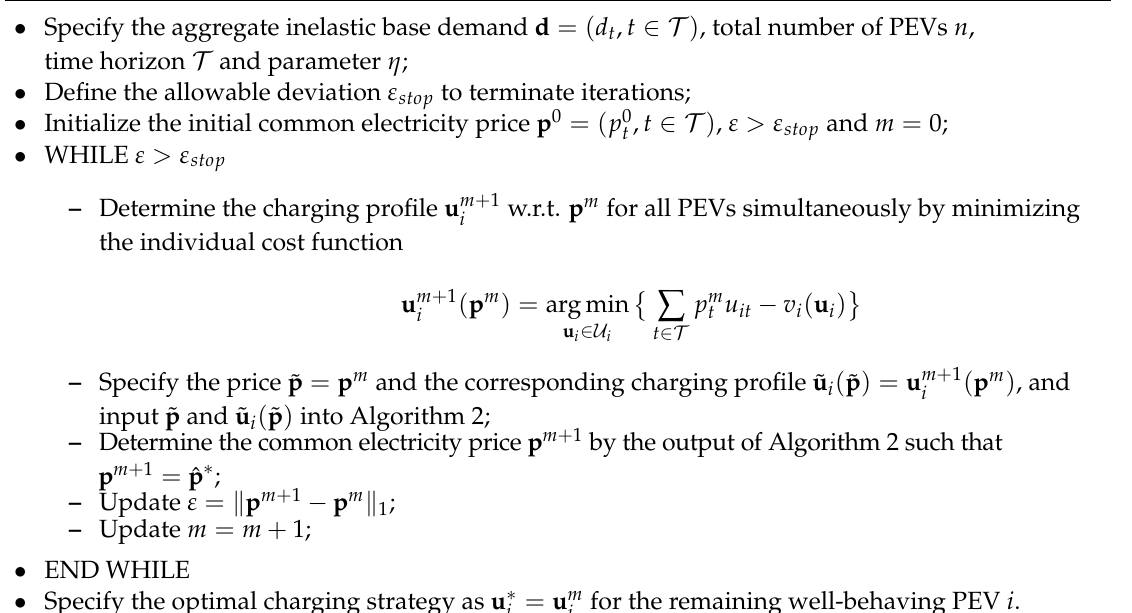
Algorithm 3: Resilient distributed coordination of PEV charging considering